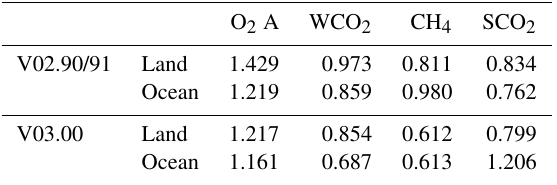
Table 4. Root mean squares of the averaged spectral residuals